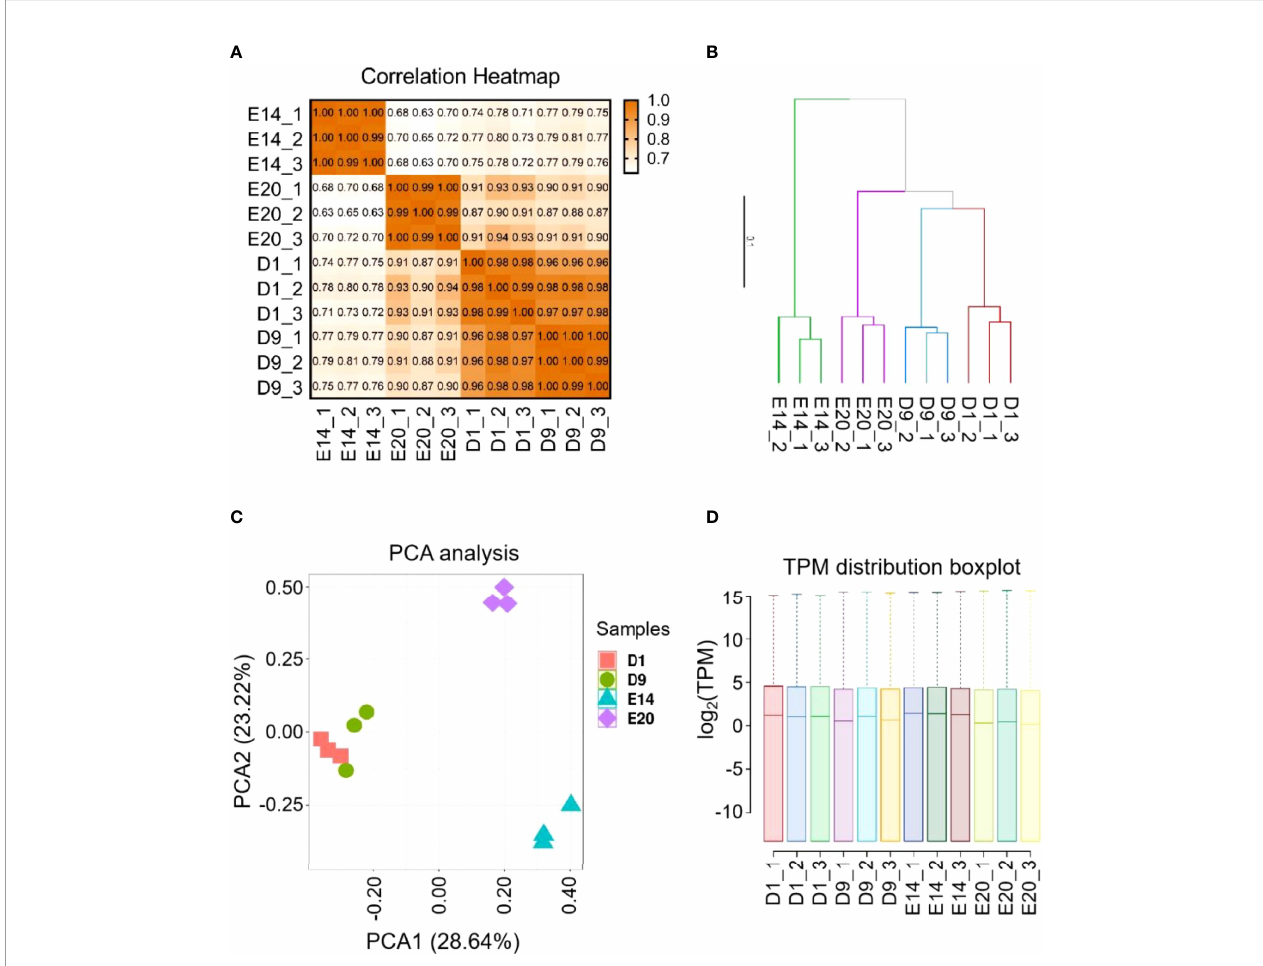
FIGURE 1 | RNA-Seq library characteristics of chick subcutaneous adipose tissue in four development stages. (A) Correction analysis of 12 RNA-Seq library of chick subcutaneous adipose tissue in four development stages; (B) cluster analysis of 12 RNA-Seq library of chick subcutaneous adipose tissue in four development stages; (C) PCA of 12 RNA-Seq library of chick subcutaneous adipose tissue in four development stages; (D) TPM distribution box plot of 12 RNA-Seq library of chick subcutaneous adipose tissue in four development